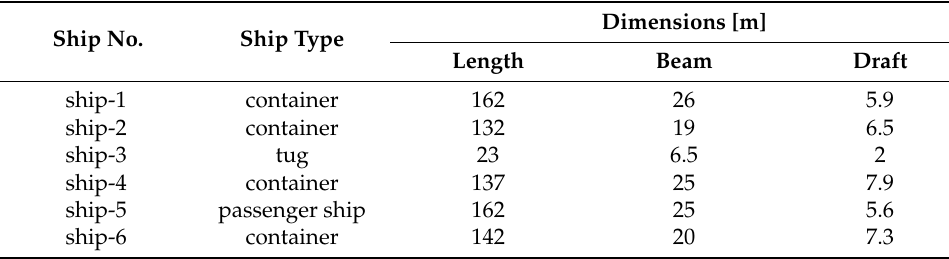
Figure 1. Shows static data from ships 1–6 navigating the VTS area of Busan Port in a collision risk situation. Six multi-ships sailed during that time, with four container ships, one ferry, and a tugboat passing each other. The ship specifications, including length, beam, and draft information, are shown in Table 1. Table 1. Ship data with dimensions and ship